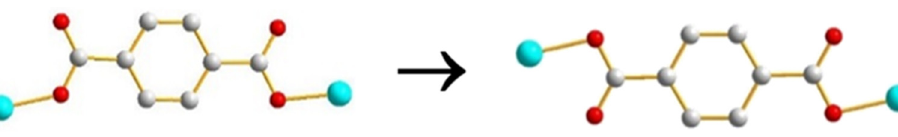
Figure 9. A drawing showing the cis → trans isomerization in the Cu 2 -1,4-BDC 2 − units.